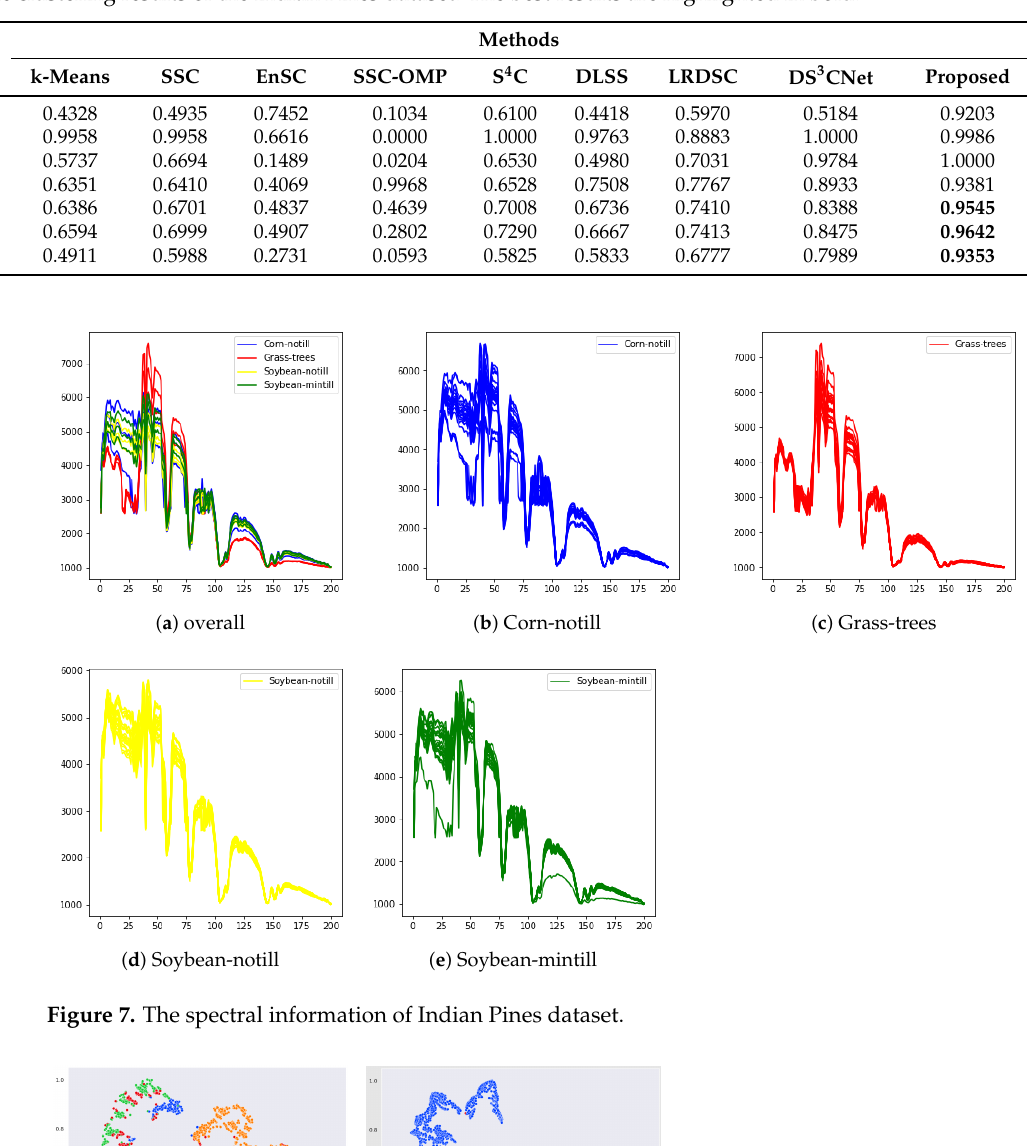
Table 4. The clustering results of the Indian Pines dataset. The best results are highlighted in bold.